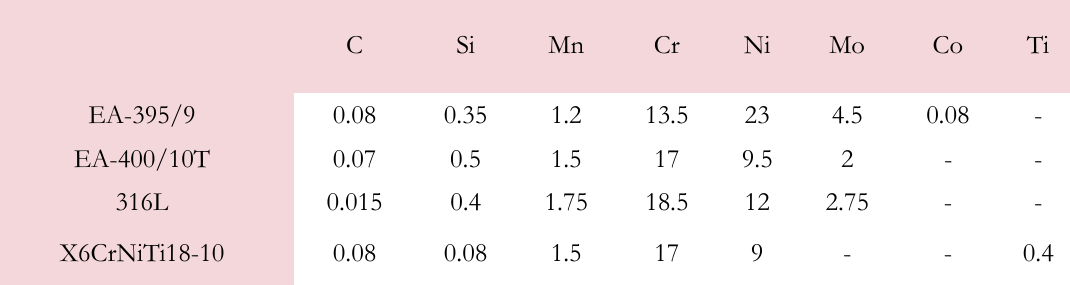
Table 2: Chemical composition of stainless steels (wt %).